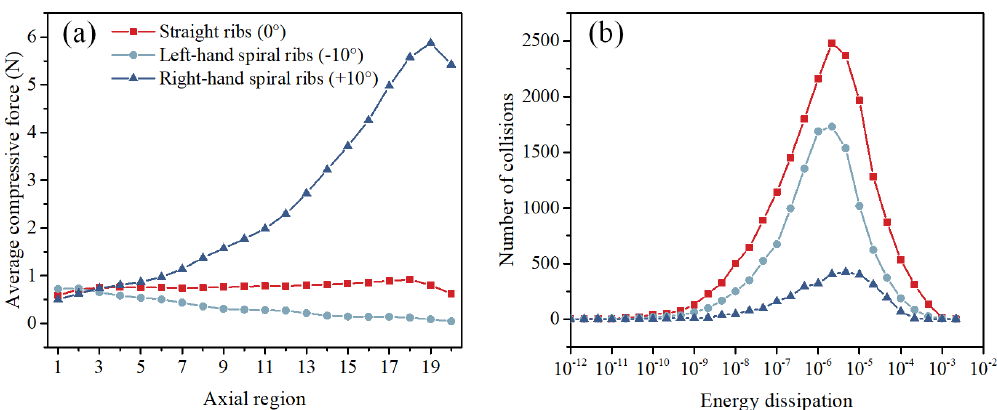
Figure 9. (a) Average compressive force under different spiral angles of convex ribs. (b) The distribution of energy dissipation during the particle collisions.